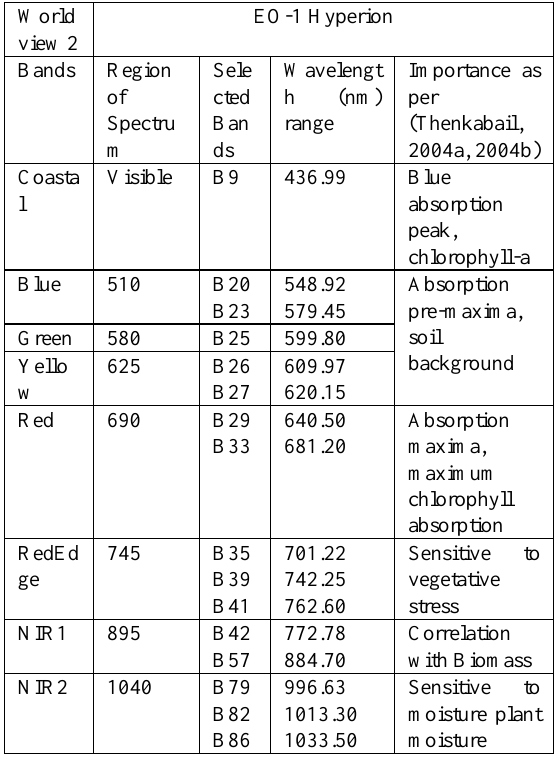
Figure 4. SNR of EO-1 Hyperion data (summer season)